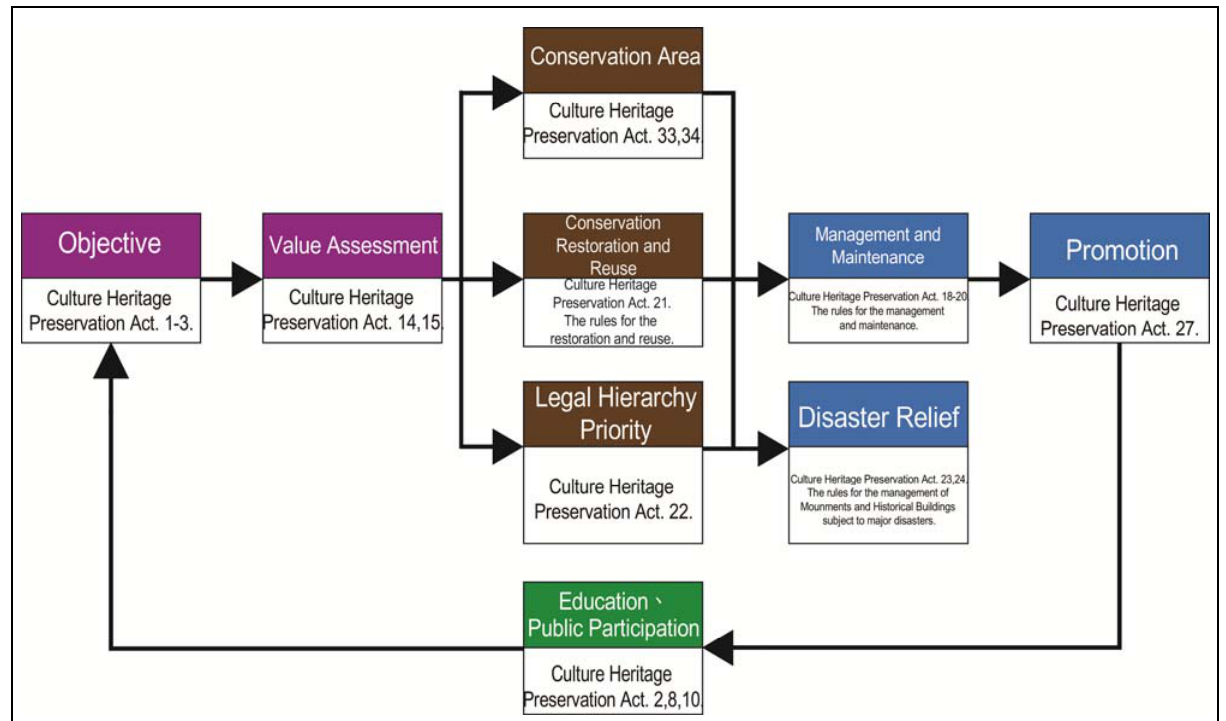
Figure 1. Legal framework for the conservation,